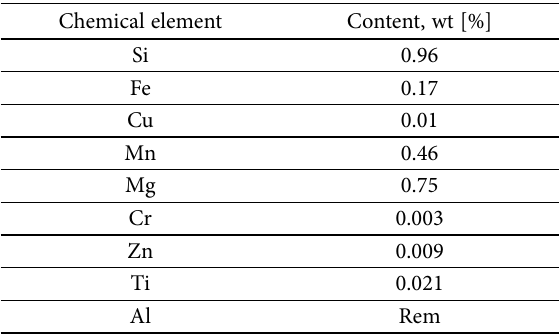
Table 2. Mechanical properties and requirements to extruded